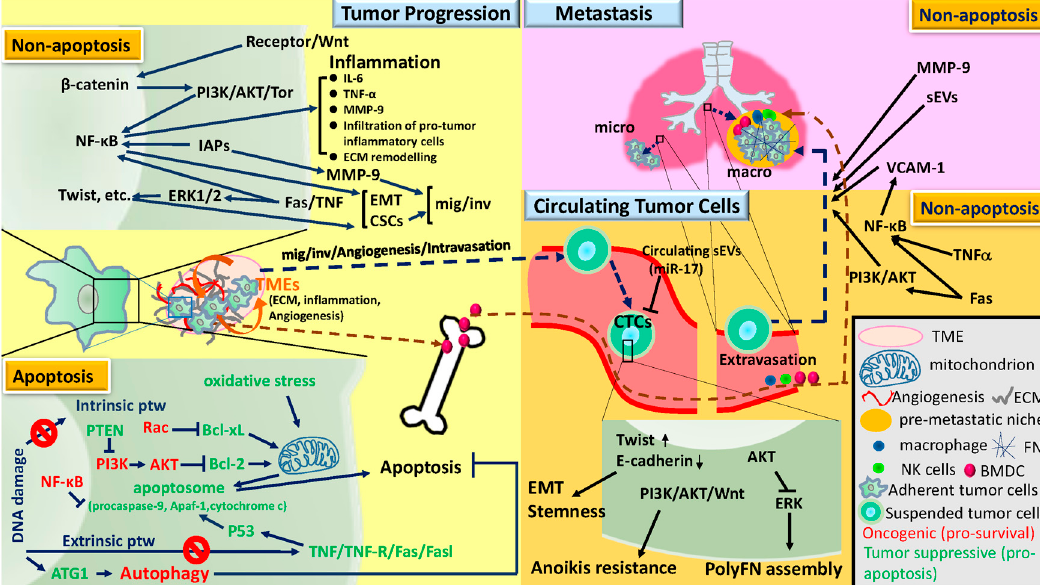
Figure 1. Genes and pathways involved in the tumor progression toward cancer metastasis. Metastasis is the final stage of a chronic tumor progression, starting from tumor transformation followed by early progression within the primary tumor tissues, blood-borne to become circulating tumor cells (CTCs), colonization into distant organs in which pre-metastatic niche has been built, and outgrowth as secondary tumor tissues. Listed are signaling pathways associated with intrinsic and extrinsic stimulations for apoptosis and with apoptosis-independent activities. Note: The genes marked in green are considered tumor suppressive and in red oncogenic. The arrows with broken lines indicate the directions and locations toward which particular cells are moving. The corresponding full names abbreviated are listed as follows: TMEs, tumor microenvironments; ECM, extracellular matrix; micro, micrometastasis; macro, macrometastasis; FN, fibronectin; BMDC, bone marrow derived cells; TNF, tumor necrosis factor family, ptw, pathway; mig, migration; inv, invasion.